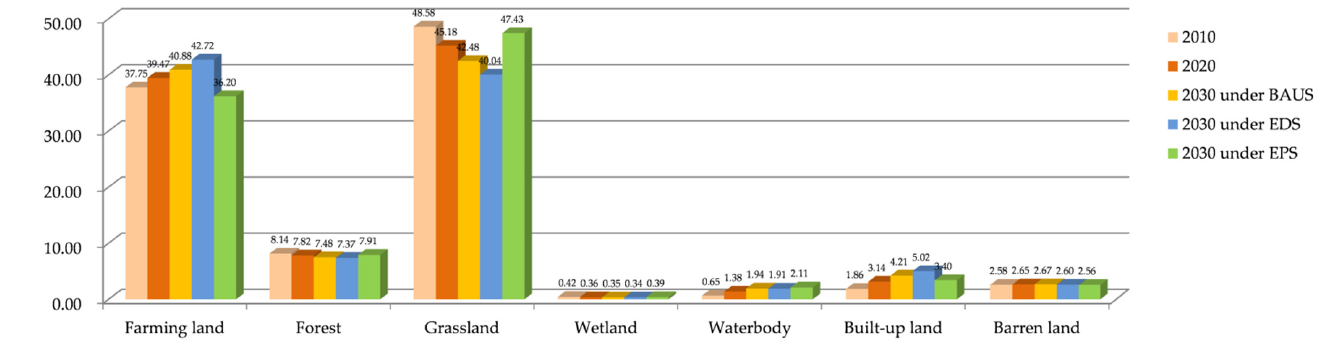
Figure 6. Area percentage of land use in the farming–pastoral ecotone of northern China.